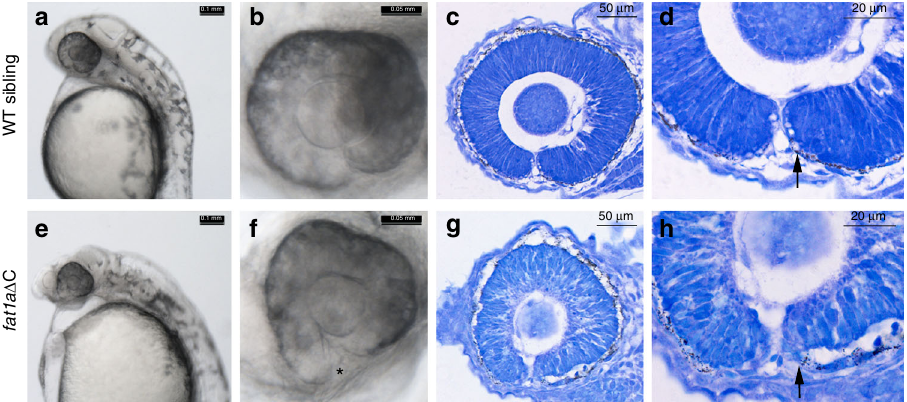
Fig. 5 Zebra fi sh embryos with homozygous alleles of truncated fat1a display coloboma. CRISPR/Cas9-mediated introduction of frame-shift mutations in FAT1 C-terminal resulted in optic fi ssure closure defects ( a and e , scale bar is 0.1 mm). A higher magni fi cation of eye depicting fused margins in WT and unfused margins in homozygous mutant (*, b and f , scale bar is 0.05 mm). Sagittal sections of zebra fi sh embryos (24 – 30 hpf) followed by toludene blue staining showing organization of the optic cup ( c and g , scale bar is 50 µ m). Higher magni fi cation of the optic cup shows morphology of optic fi ssure margins in WT and homozygous mutant ( d , h , scale bar is 20